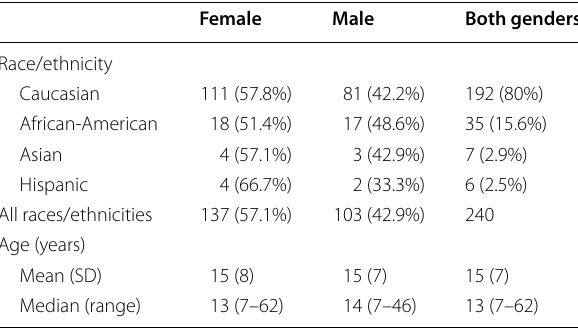
Table 1 Characteristics of the non-syndromic tooth